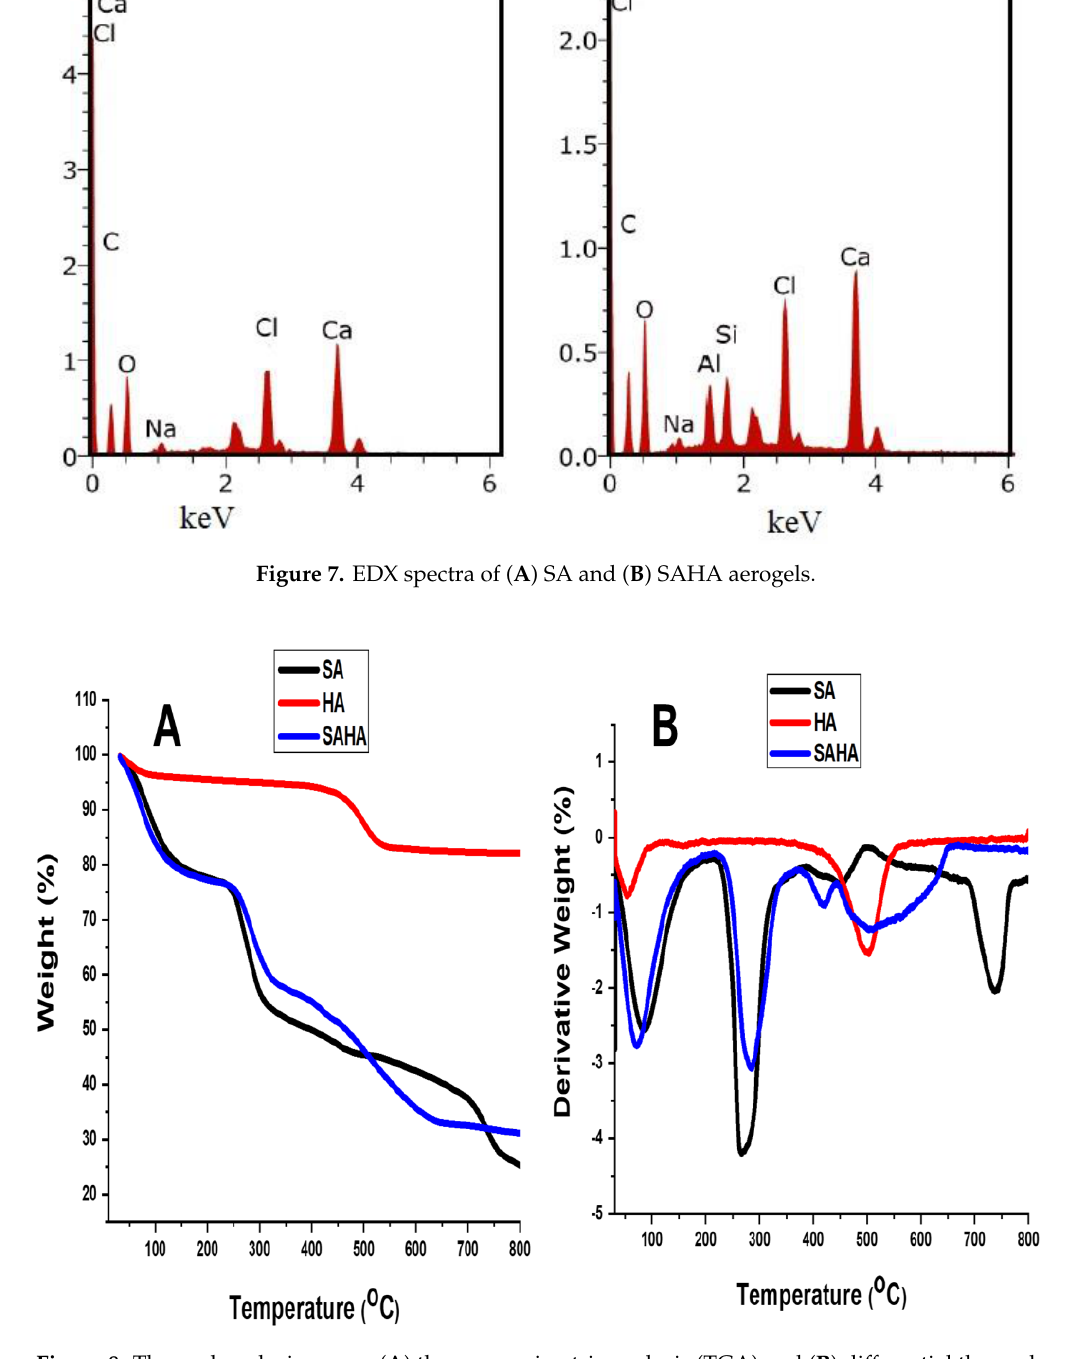
Figure 8. Thermal analysis curves ( A ) thermogravimetric analysis (TGA) and ( B ) differential thermal analysis (DTA) curves of halloysite clay (HA), SA, and SAHA.